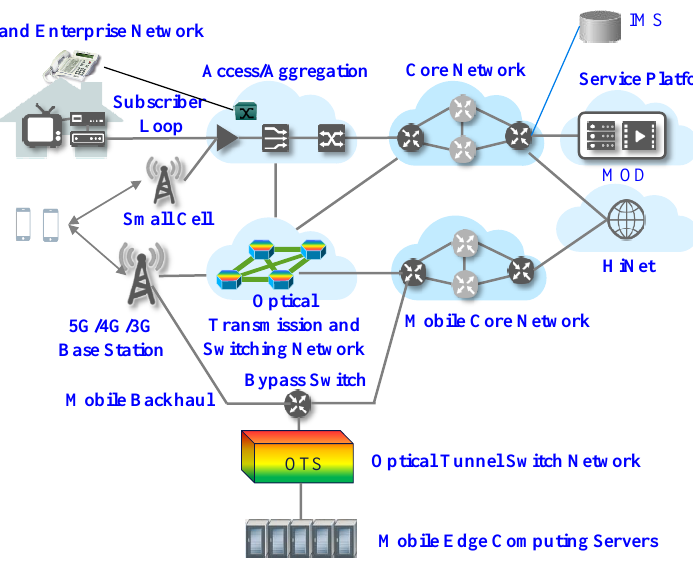
Figure 20. Application of Torus topology optical tunnel switching network.